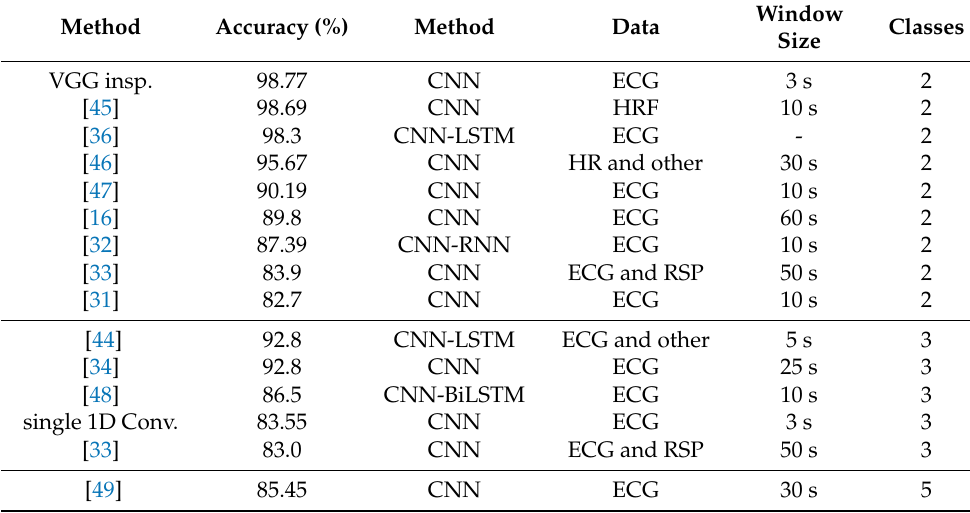
Table 8. Stress classification using heart related